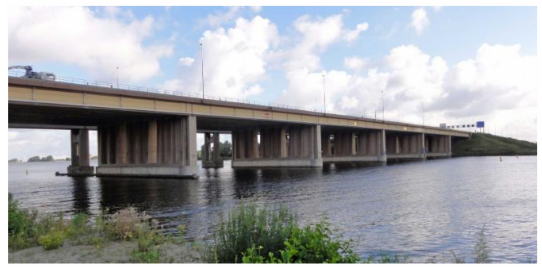
Figure 1. Picture of the Hollandse